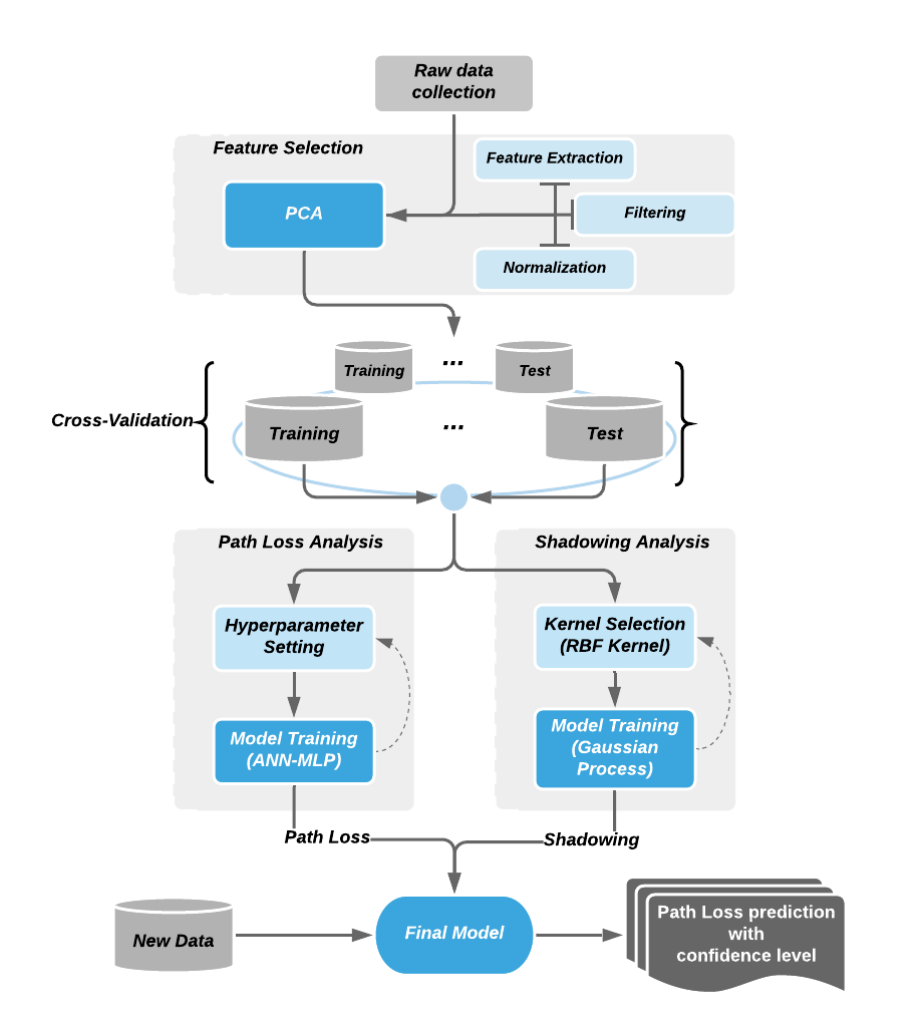
Figure 2. Procedure of machine-learning-based path loss